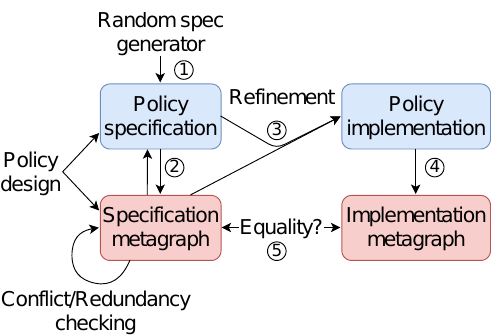
Figure 9. Enabling policy verification using metagraphs. We propose 4 tools: 1 RandomWork- flowSpecGenerator; 2 3 SpecToRego; 4 RegoToMetagraph; 5